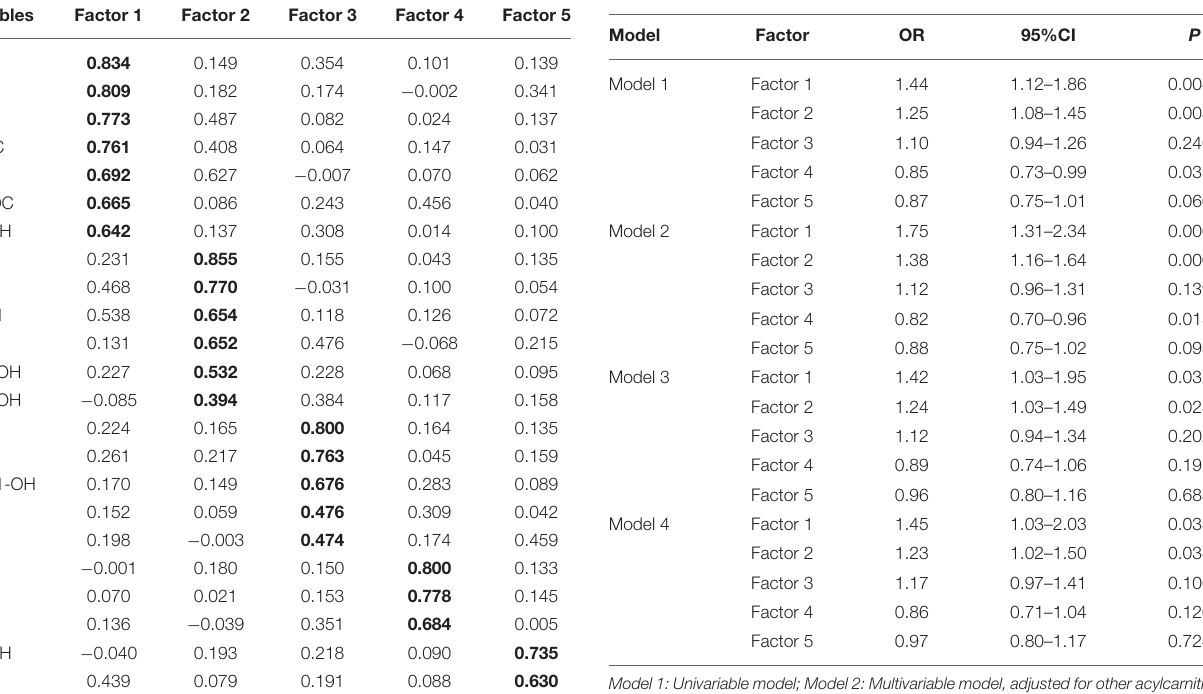
TABLE 4 | Univariable and multivariable association of metabolomic factors with cardiovascular event. Model Factor